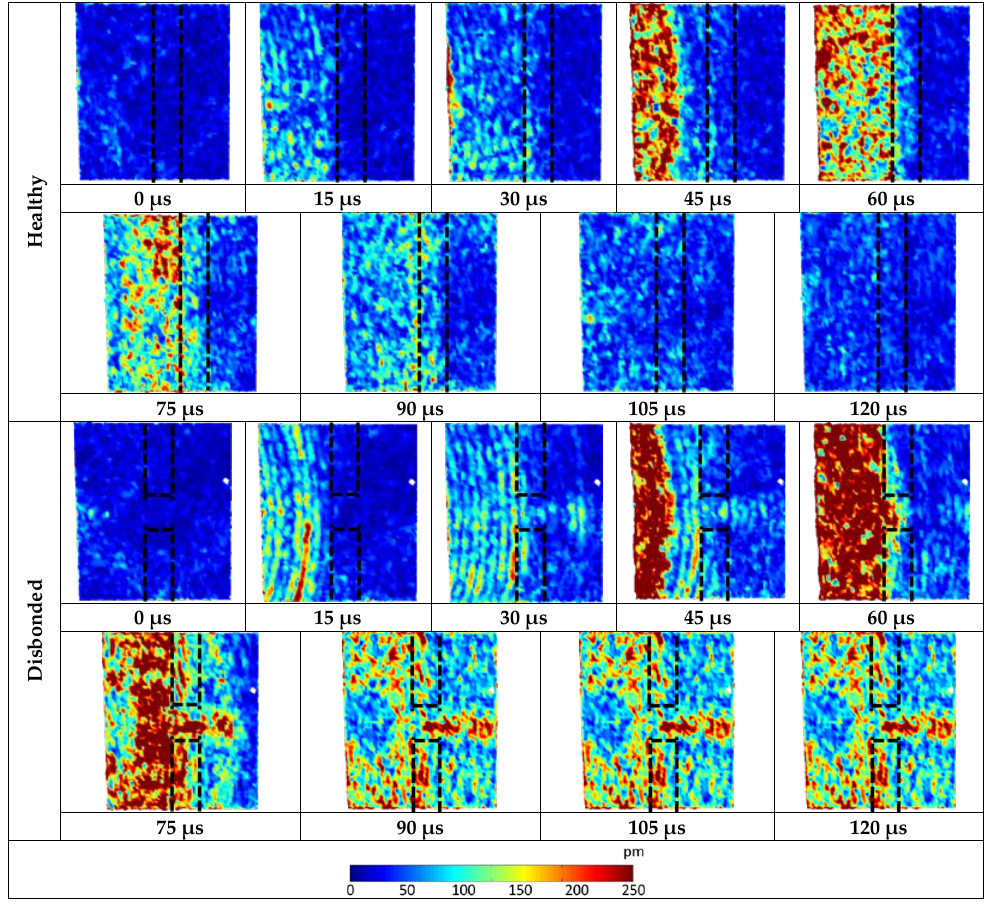
Figure 8. 300 kHz three-component displacement magnitude showing Lamb wave interaction with the healthy and disbonded stiffened panel.